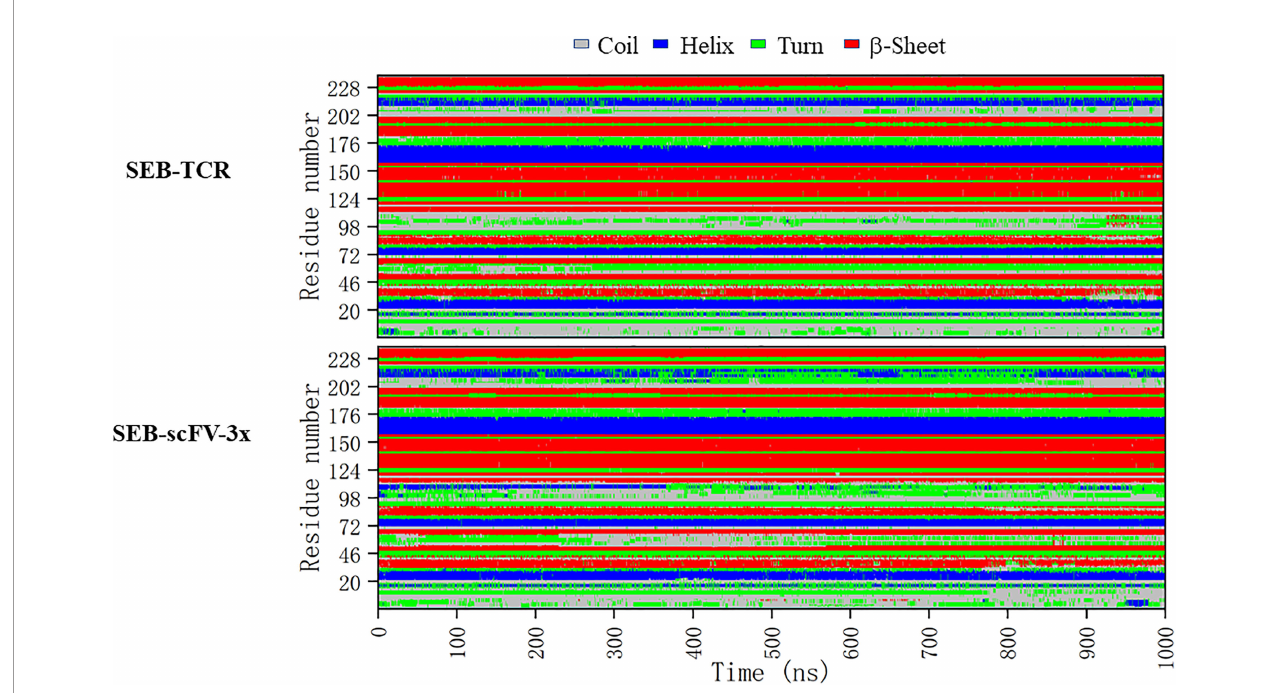
FIGURE 9 | Comparison of secondary structure changes of SEB-TCR and SEB-scFV-3x during 1000 ns simulation. Regions around loop2 residue 95-105 and residues 202-228 has the largest